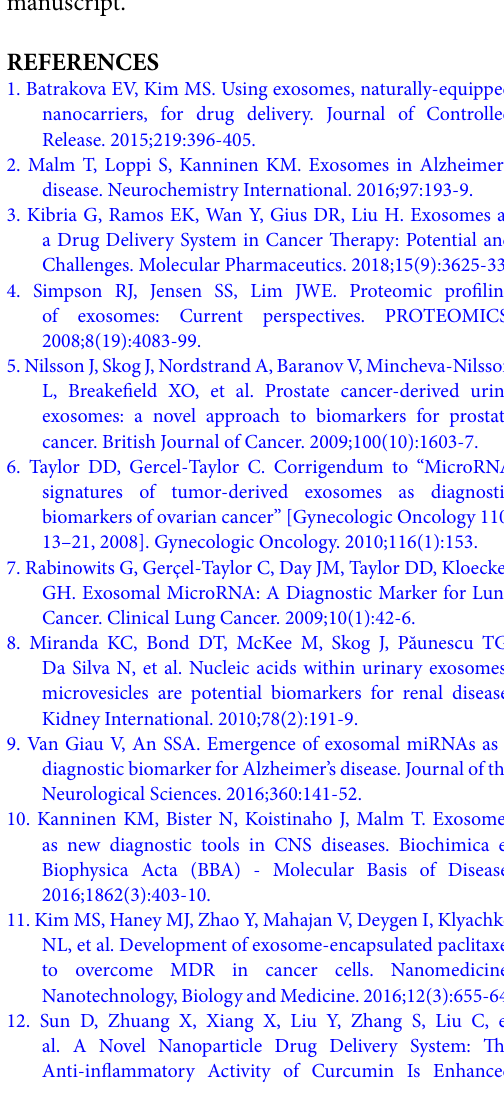
245 Nanomed Res J 4(4): 239-246, Autumn